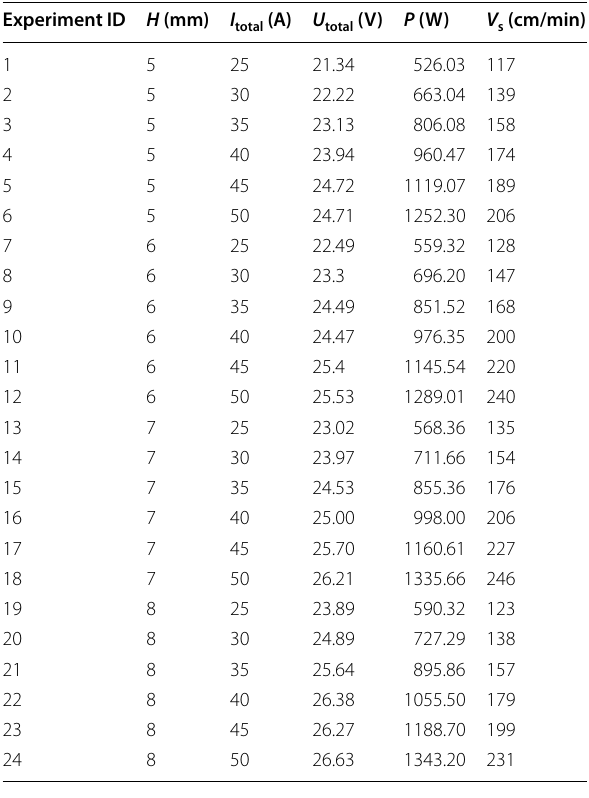
Table 3 Sets of processing parameters and their respective outcomes